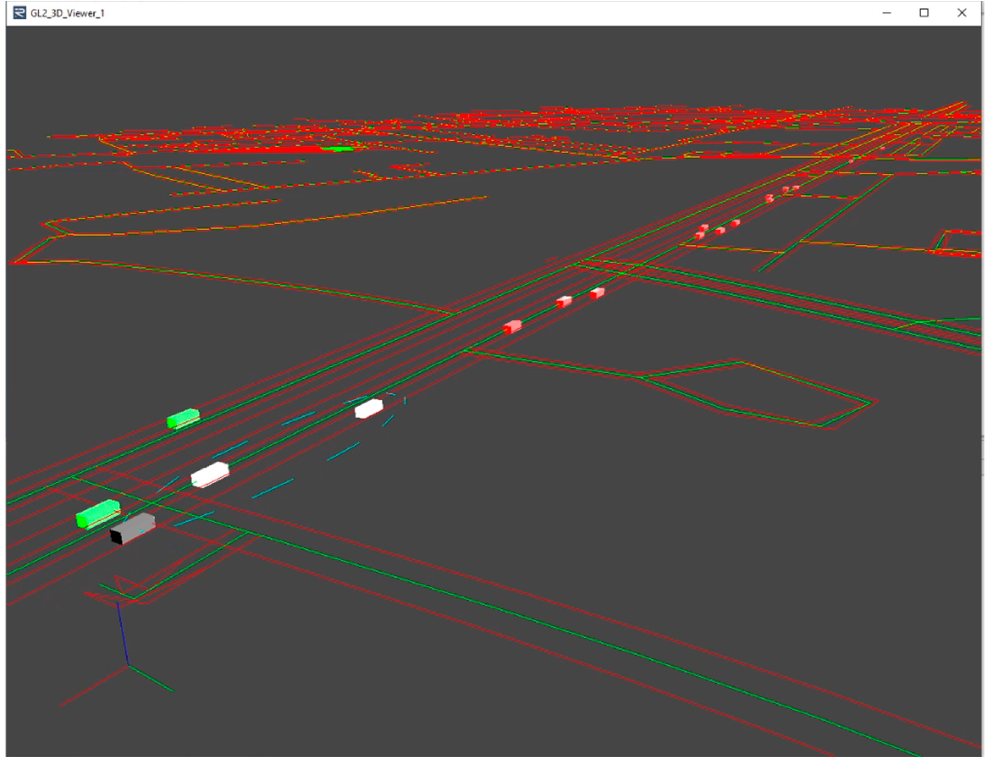
Figure 6. 3D visualisation of an SUMO simulation with its corresponding road data from OSM maps.